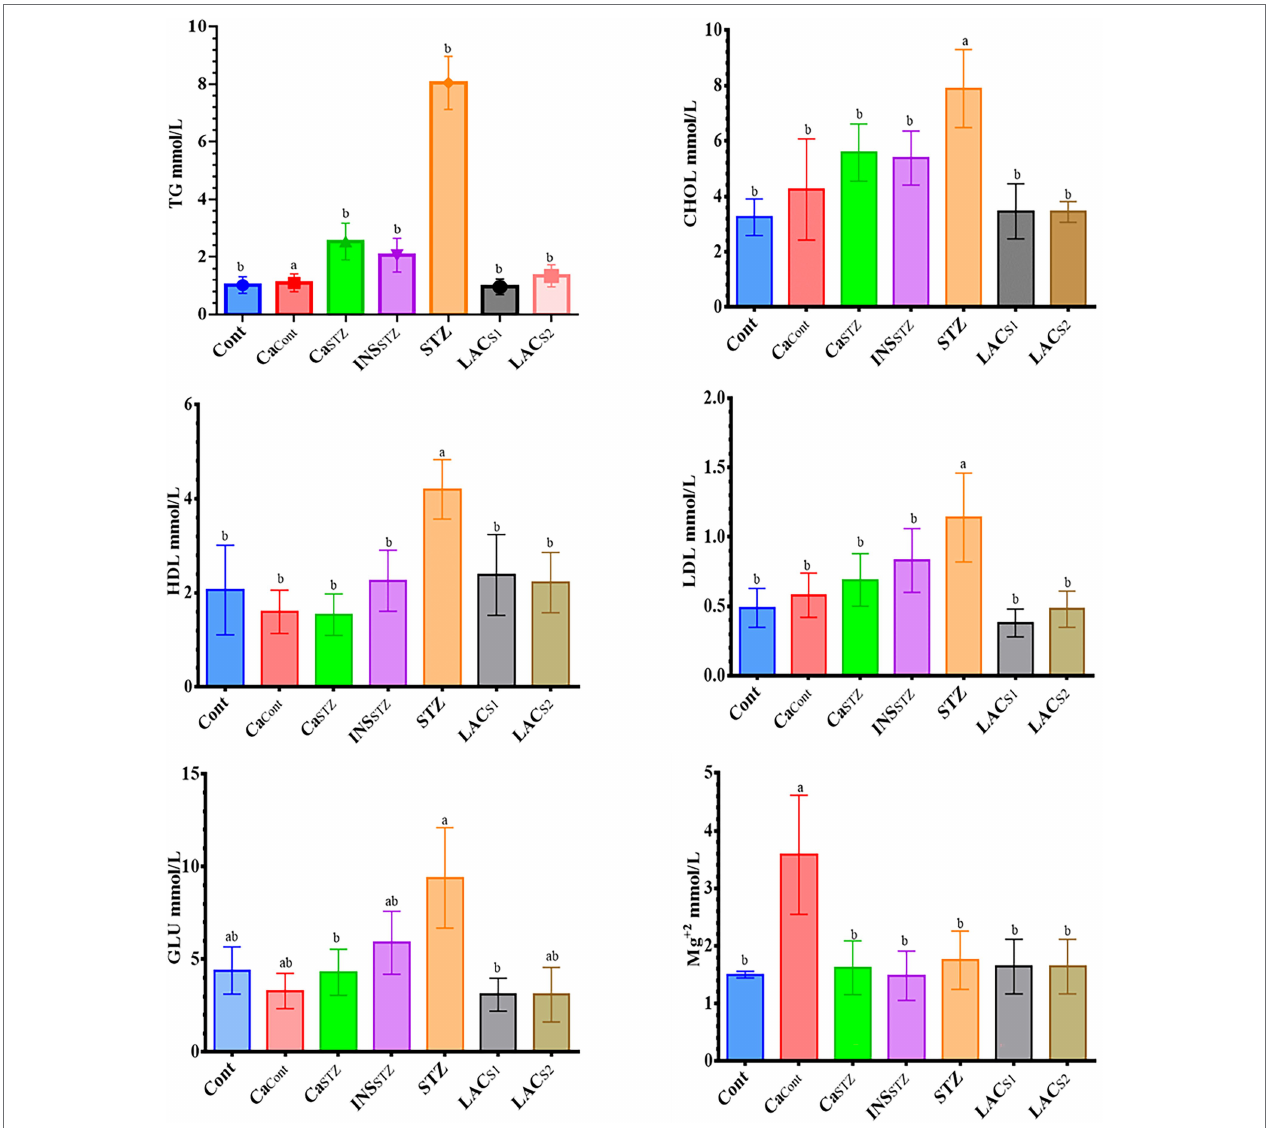
FIGURE 3 | Hyperlipidemia parameters, glucose and Mg +2 level analysis in blood plasma. Cont , control; Ca Cont , camel milk control; Ca STZ , camel milk with streptozotocin; INS STZ , insulin with streptozotocin; STZ , streptozotocin; LAC SI , KLDS 1.0727 with streptozotocin; LAC S2 , KLDS 1.0373 with streptozotocin. Result are given in triplicate as mean ± SD. Different letters indicate significant differences among groups ( p < 0.05). TG, triglycerides; CHOL, total cholesterol; HDL, high-density lipoprotein cholesterol; LDL, low-density lipoprotein cholesterol; GLU,